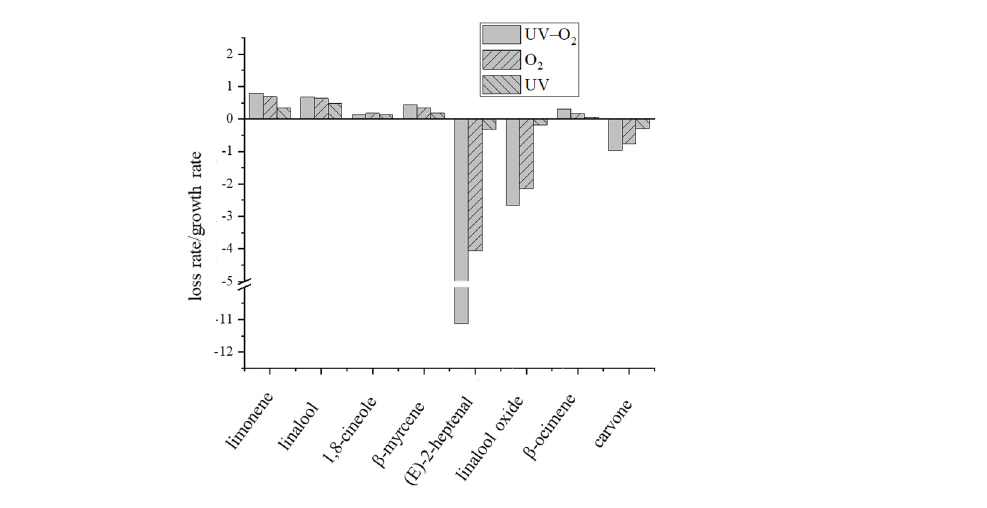
Figure 3. Loss rate/growth rate of key aroma compounds under different storage conditions. Stor- age conditions: UV (UV irradiation), O 2 (oxygen exposure), UV–O 2 (UV irradiation—oxygen expo- sure); control sample (con); day (d).